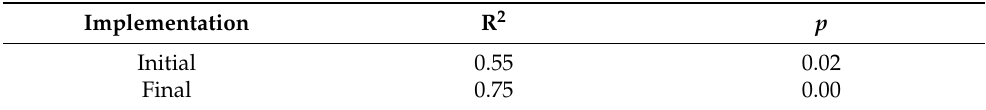
Table 6. Correlation of development of social entrepreneurship and complex thinking competencies (Initial–Final).